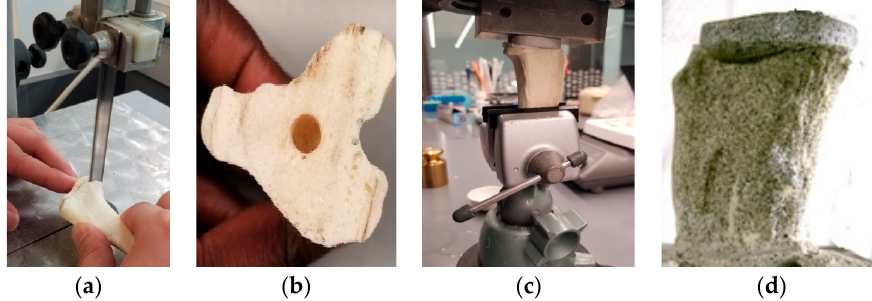
Figure 3. Process to create experimental TT–bone samples. ( a ) Proximal tibia cut using a butcher saw, ( b ) Drilled TT keel hole to secure tibial tray using bone cement, ( c ) Maintenance of alignment during the curing of a tibial tray in bone using bone cement, ( d ) a white and black spray-painted TT–bone sample that is used for mechanical tests.